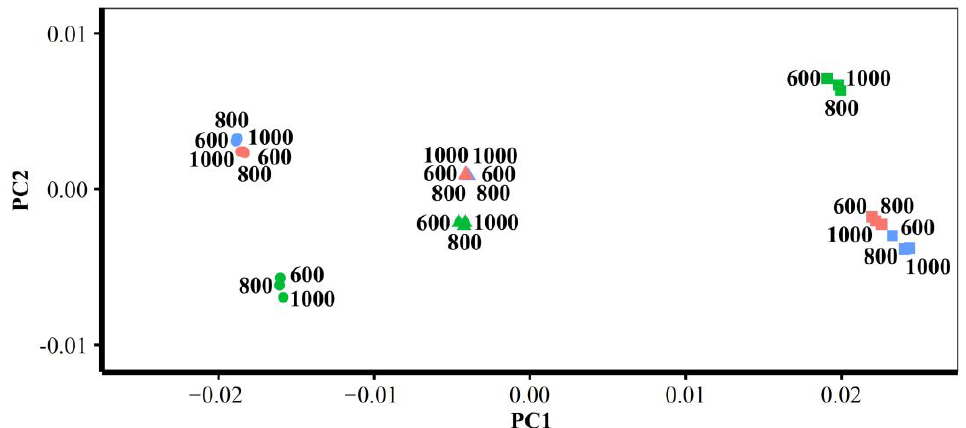
Figure 17. PC1 (92.4% of total variance) vs. PC2 (4.7%) from PCA of the mean and allometrically scaled head surfaces derived using varying densities of semilandmarks and each semilandmarking approach. Triangles = means, squares = allometric predictions of surfaces at the sample minimum centroid size, circles = allometric predictions of surfaces at the sample maximum centroid size. Red = sliding TPS, blue = TPS&NICP, green = LS&ICP. Numbers indicate number of semilandmarks. The sliding TPS and TPS&NICP means are nearly superimposed.